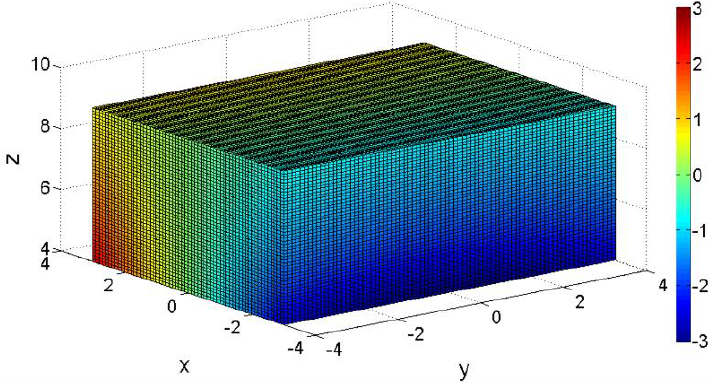
Figure 2. Distribution of voltage equivalent points in space plotted by Matlab R2014a.